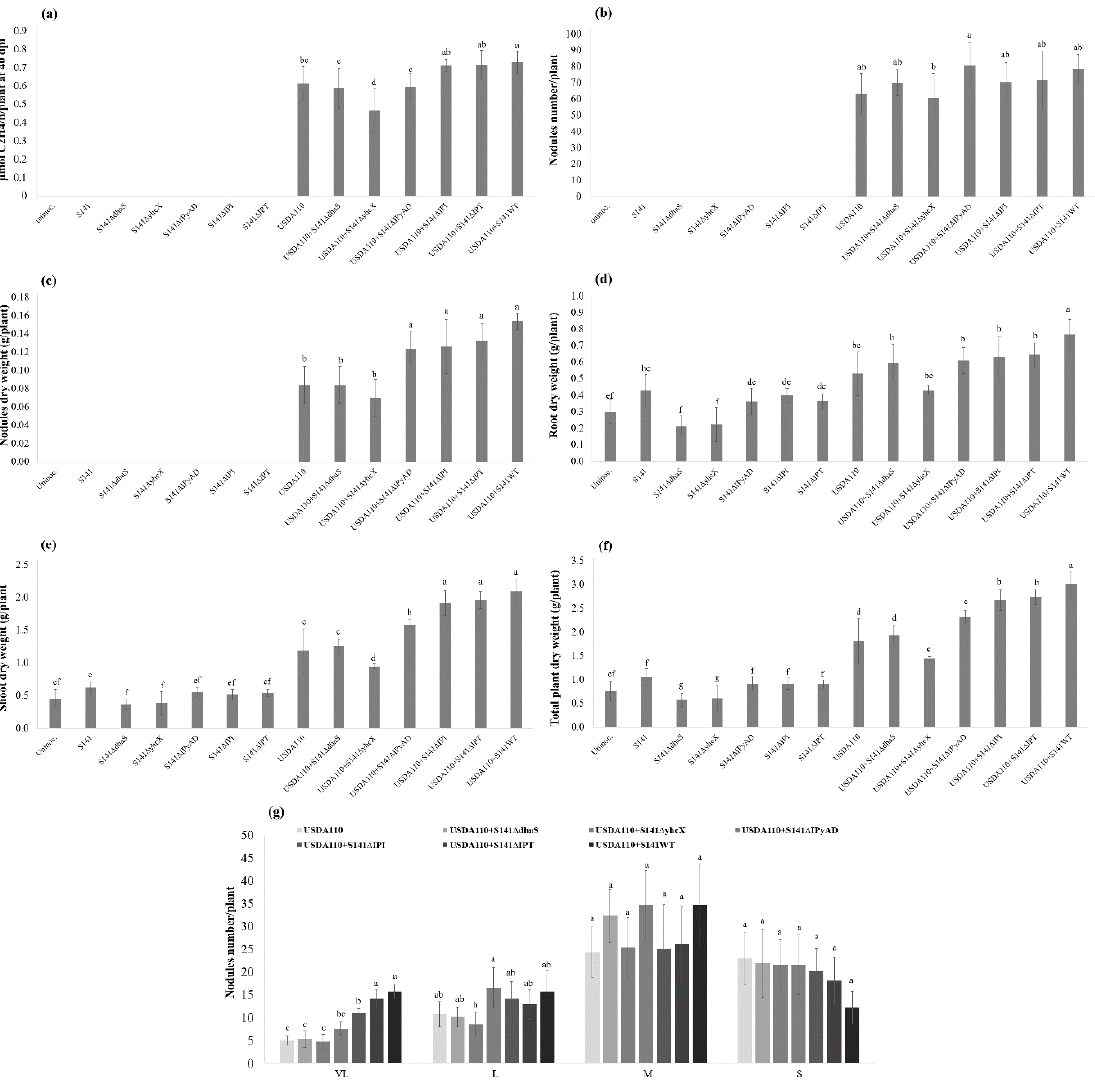
Figure 8. Plant growth parameters of soybean cultivar Chiang Mai 60 by co - inoculation with USDA110 and S141 or S141 mutant strains compared with single inoculation at 45 DAI : ( a ) nitrogenase activity was determined using the acetylene reduction assay; ( b ) nodule numbers per plant; ( c ) nodule dry weight; ( d ) root dry weight; ( e ) shoot dry weight; ( f ) total plant dry weight; and ( g ) nodule size separation . Significance at p ≤ 0 . 05 is indicated by mean standard error bars ( n = 8 ). The effect of co - inoculation between USDA110 and S141 or S141 IAA - related mutant strains including S141 Δ dhaS , S141 Δ yhcX , and S141 Δ IPyAD complemented by the addition of 3 . 58, 3 . 65, and